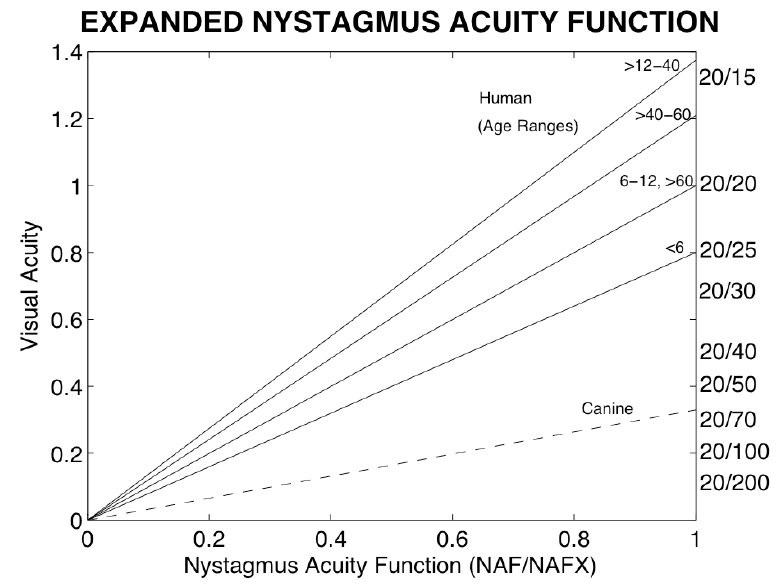
FIGURE 3. Relationship between NAFX and Snellen acuity for patients of different ages and for